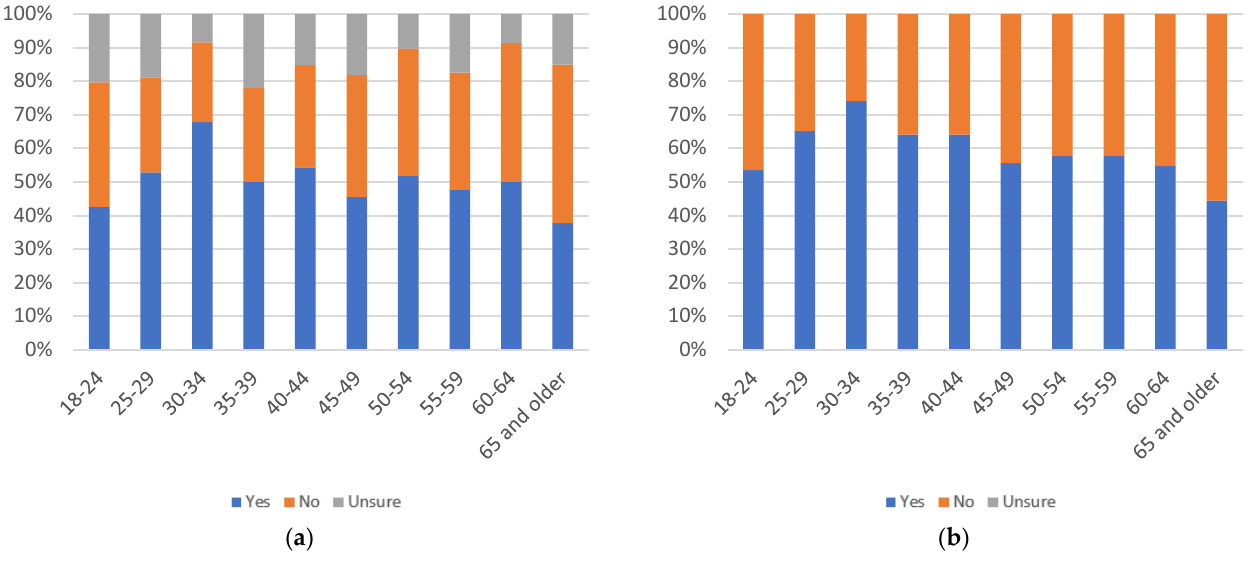
Figure 107. Label use, by age group: ( a ) with uncertain respondents (left) and ( b ) without uncertain respondents (right).